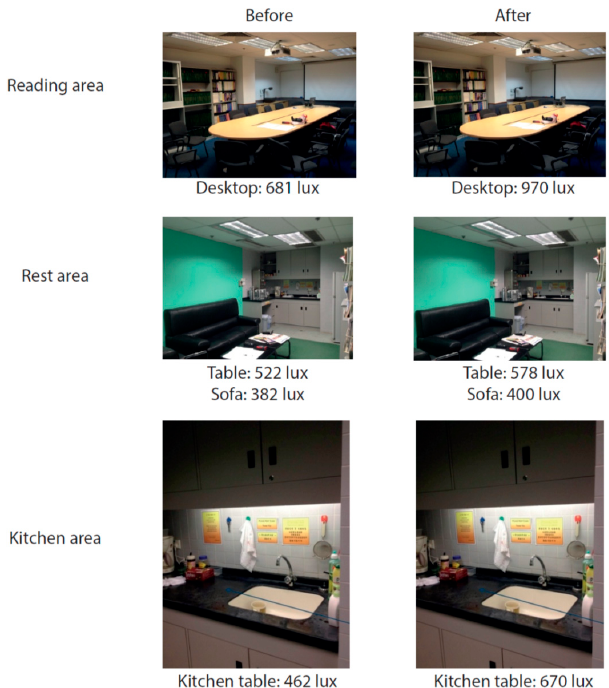
Figure 10. Lighting before and after the retrofit.